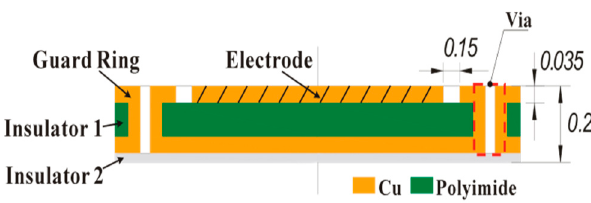
Figure 19. The schematic diagram of the sensing electrode group cross-sectional structure (unit: mm).